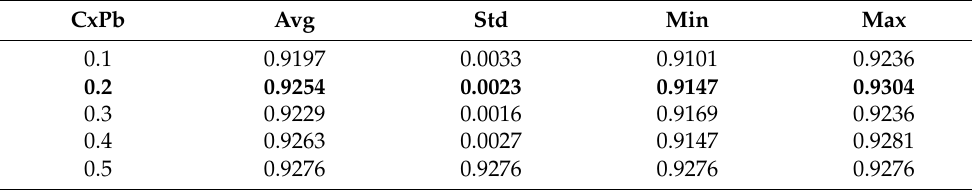
Table 6. Results varying the value of crossover probability (CxPb).